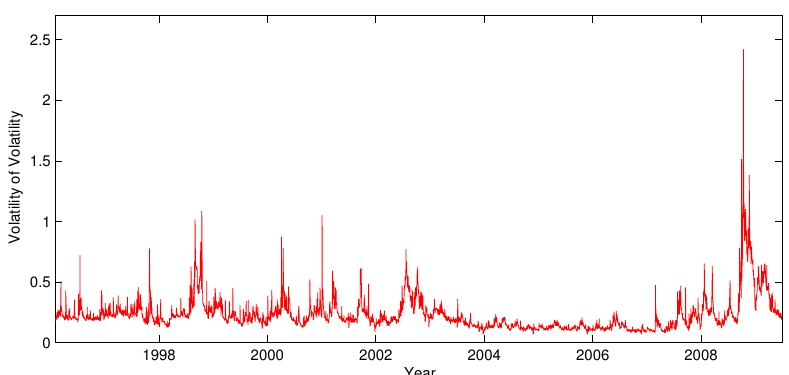
Figure 9. S&P500 estimated volatility of realized